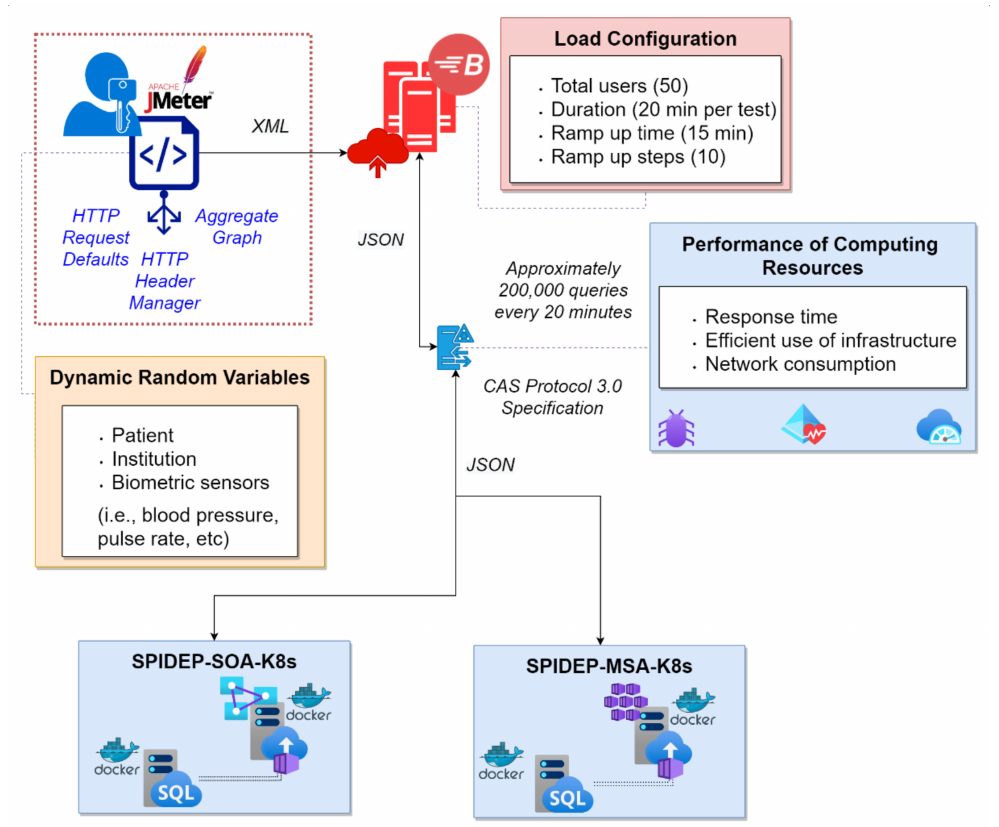
Figure 3. Process Flowchart for the simulation performed on the K8s SPIDEP